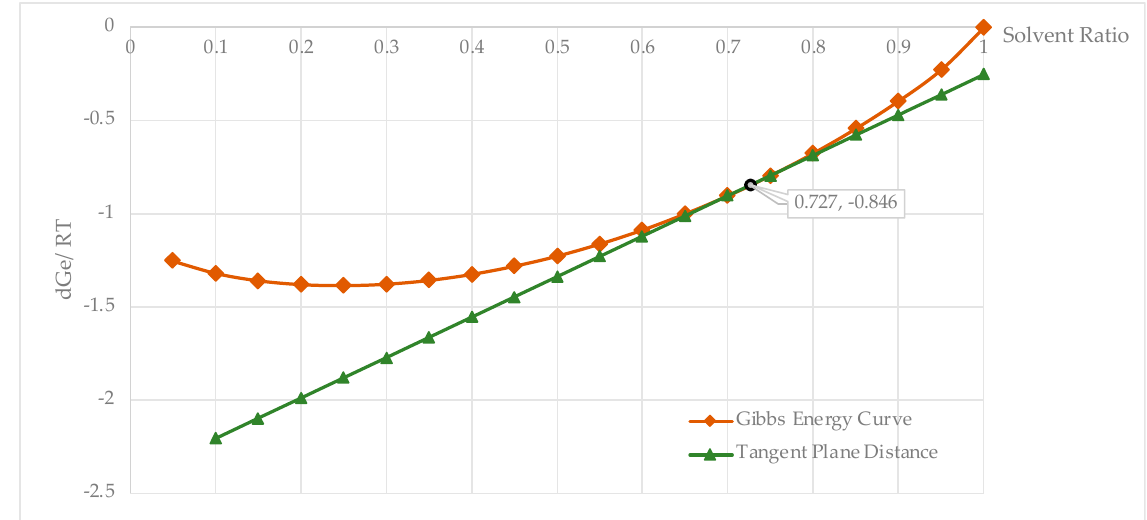
Figure 2. Gibbs energy and tangent plot for 2—Octanone in case study 1.